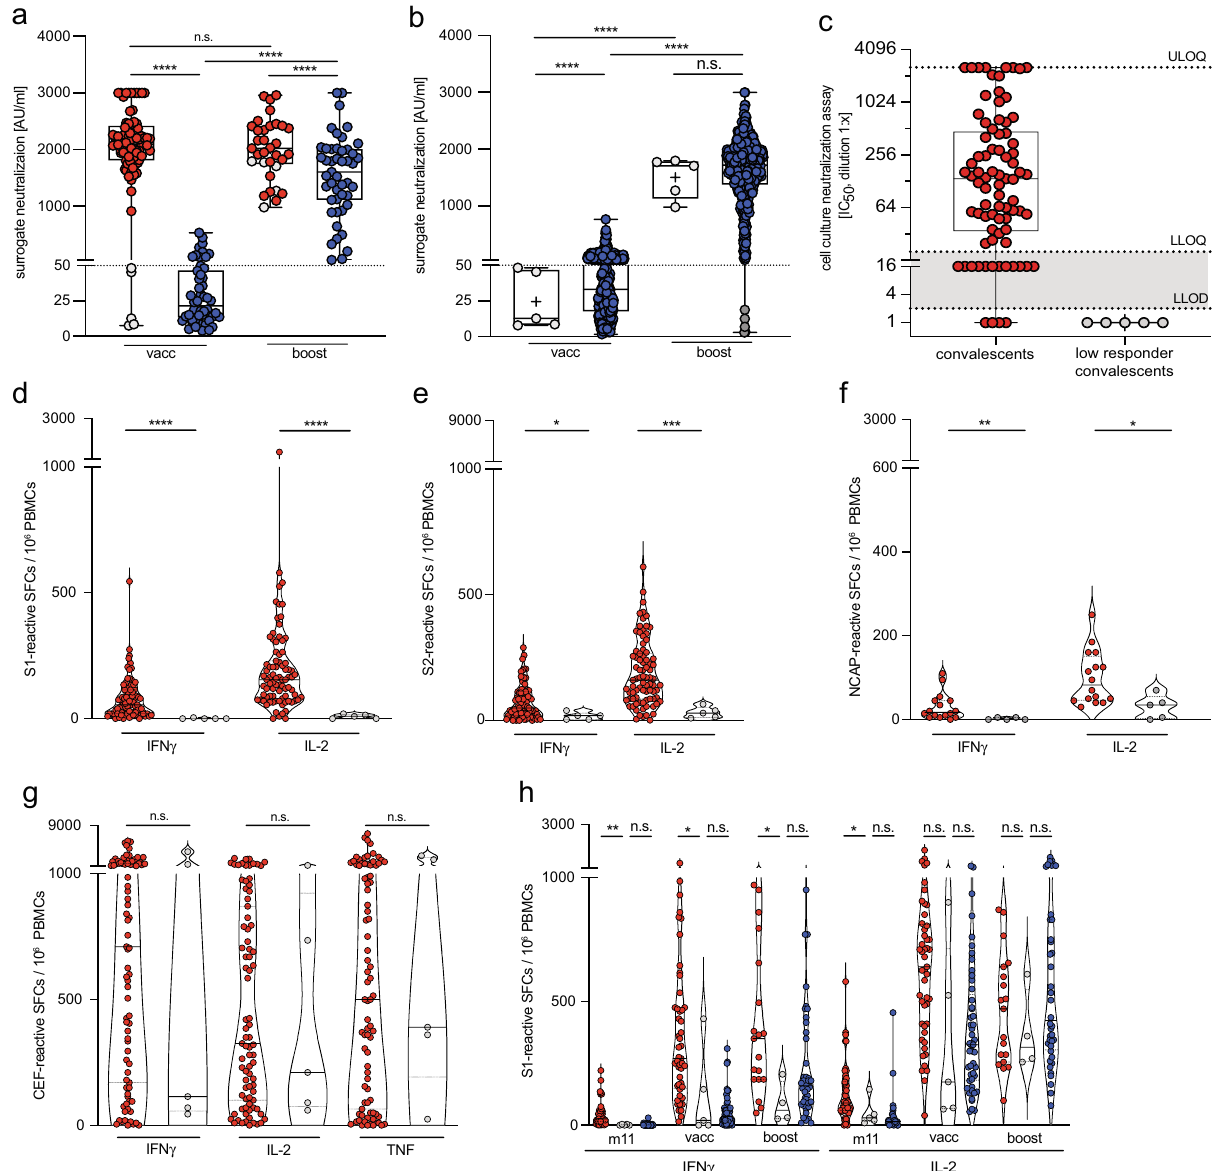
Fig. 6 Low responder convalescents respond to prime/boost BNT162b2 mRNA vaccination. ( a ) surrogate virus-neutralization after prime and boost vaccination in convalescents (red, n = 77 (vacc), n = 28 (boost)), low responder convalescents (gray, n = 5) and naïve individuals (blue, n = 51 (vacc), n = 49 (boost)). Data are shown as median (vacc: 2099 and 19, boost: 2022 and 1605) with box bounds at 25% (vacc: 1813 and 12, boost: 1742 and 1068) and 75% percentile (vacc: 2424 and 46, boost: 2414 and 2005), whiskers show maxima (vacc: 3000 and 531, boost: 2963 and 3000) and minima (vacc: 8 and 4, boost: 980 and 53). b Surrogate virus-neutralization of low responder convalescents (light gray, n = 5) and after prime and boost BNT162b2 mRNA vaccination compared to a cohort of 455 naïve individuals (blue) including low responders to vaccination (dark gray, n = 4). Data are shown as median (vacc: 13 and 33, boost: 1709 and 1723) with box bounds at 25% (vacc: 8 and 18, boost: 1126 and 1376) and 75% percentile (vacc: 47 and 68, boost: 1785 and 1981), whiskers show maxima (vacc: 48 and 764, boost: 1795 and 3000) and minima (vacc: 8 and 1, boost: 980 and 3). c Cell culture virus- neutralization activity at month 2 after SARS-CoV-2 infection in serum of convalescents ( n = 81) compared to those with low response to vaccination ( n = 5). Data is shown as median (136.4) with box bounds at 25% (34.2) and 75% percentile (479.5), whiskers show maximum (2560) and minimum (1.0). d – g Frequencies of spike-reactive, nucleocapsid-reactive or CEF-reactive cytokine-secreting cells in convalescents (red, n = 83 ( d , e , g ) and n = 16 ( f )) and low responder convalescents (gray, n = 5) at month 5 after infection. h Frequencies of spike-reactive cytokine-secreting cells at month 11 after infection, 2 weeks after prime (vacc) and 2 weeks after boost (boost) BNT162b2 mRNA vaccination; convalescents (red, n = 45 (m11), n = 49 (vacc), n = 19 (boost)), low responder convalescents (gray, n = 5 at all time points) and naïve individuals (blue, n = 39 (m11), n = 49 (vacc), n = 40 (boost)). Statistical analyses by ANOVA, two-sided Mann – Whitney and two-sided Wilcoxon signed-rank tests ( a , b , d – h ). n.s. denotes not signi fi cant; * p < 0.05; ** p < 0.01; *** p < 0.001; **** p <